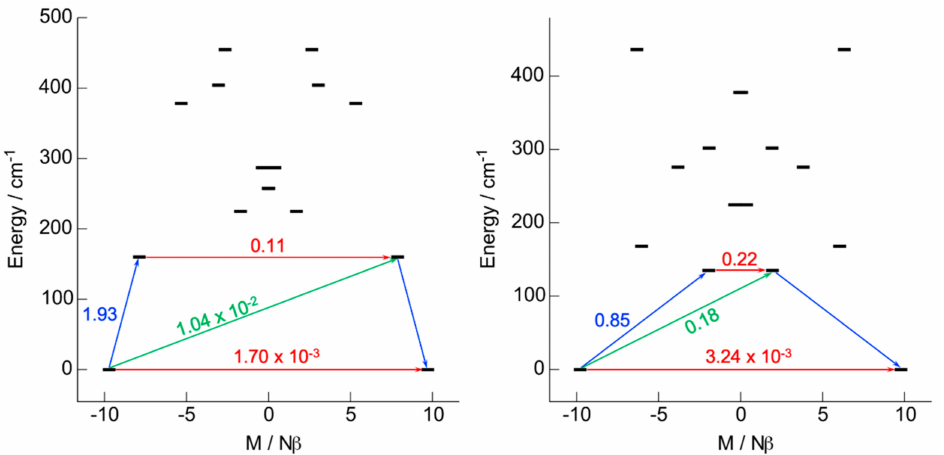
Figure 3. Energies (in cm − 1 ) and M (in N β ) (where N β = Bohr Magnetons) values for the Kramers doublet states of 1 ( Left ) and 2 ( Right ). The values of the magnetic (i.e., isotropic Zeeman) transition moments between the states are given for comparison. The horizontal red values correspond to QTM (for the GS) and Thermal Activated (TA)-QTM (for the ESs) mechanisms of the magnetization relaxation, whereas the blue and green arrows correspond to thermal and Orbach mechanisms,